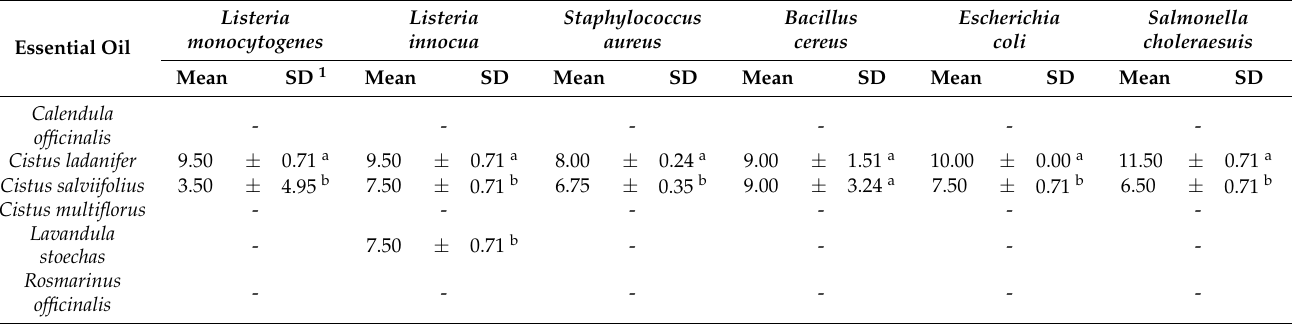
Table 2. Activity of different essential oils obtained from aromatic plants against pathogenic bacteria, expressed as the diameter of inhibition zones in